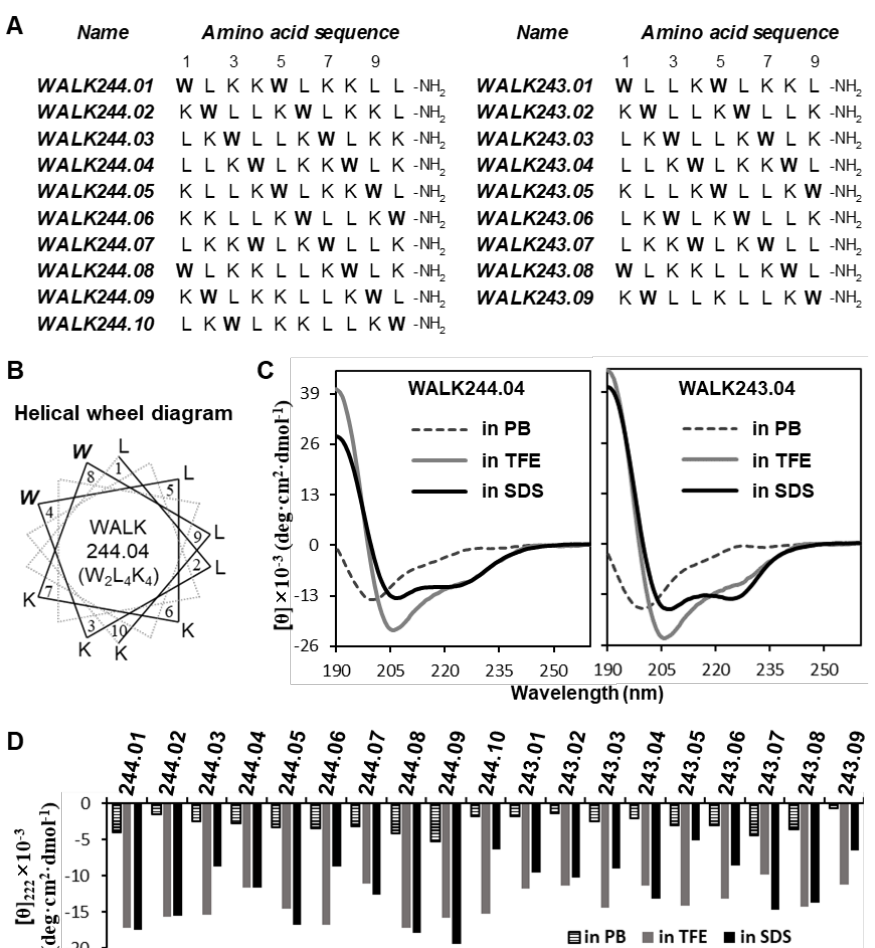
Figure 1. Sequence design and conformational validation of WALK peptides. ( A ) Amino acid sequences of individual WALK244 and WALK243 peptides. Tryptophan (W) residues are indicated in bold. ( B ) An example of a helical wheel diagram illustrated for the WALK244.04 peptide. The diagrams for other peptides are provided in Supplementary Figure S1. ( C ) Examples of far-UV CD spectra demonstrated for WALK244.04 and WALK243.04 peptides. The spectra of the other peptides are represented in Supplementary Figure S2. Individual peptide samples (100 μM) were dissolved in 10 mM sodium phosphate buffer alone (dashed line; PB), PB containing 50% ( v / v ) trifluoroethanol (gray line; TFE), and PB containing 10 mM sodium dodecyl sulfate (black solid line; SDS). ( D ) Comparison of CD spectroscopic parameters. Mean residue molar ellipticities of each WALK peptide at 222 nm ([θ] 222 ) in different solvents are summarized: PB (scratched bar), TFE (gray bar), and SDS (black bar).